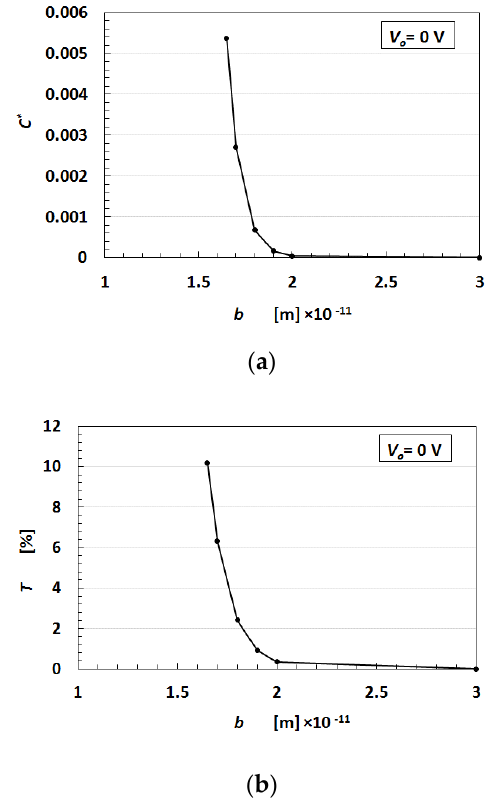
Figure A5. Theoretical results based on tunnel theory from previous studies [5,24]; ( a ) transmitted probability; ( b ) dimensionless capacitance.